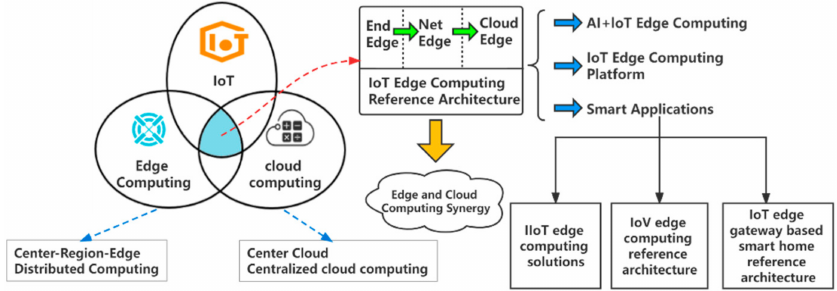
Figure 1. The Connection Between IoT, Edge Computing and Cloud